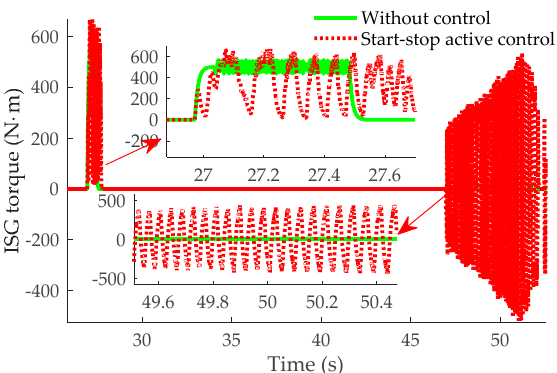
Figure 16. Engine output torque.